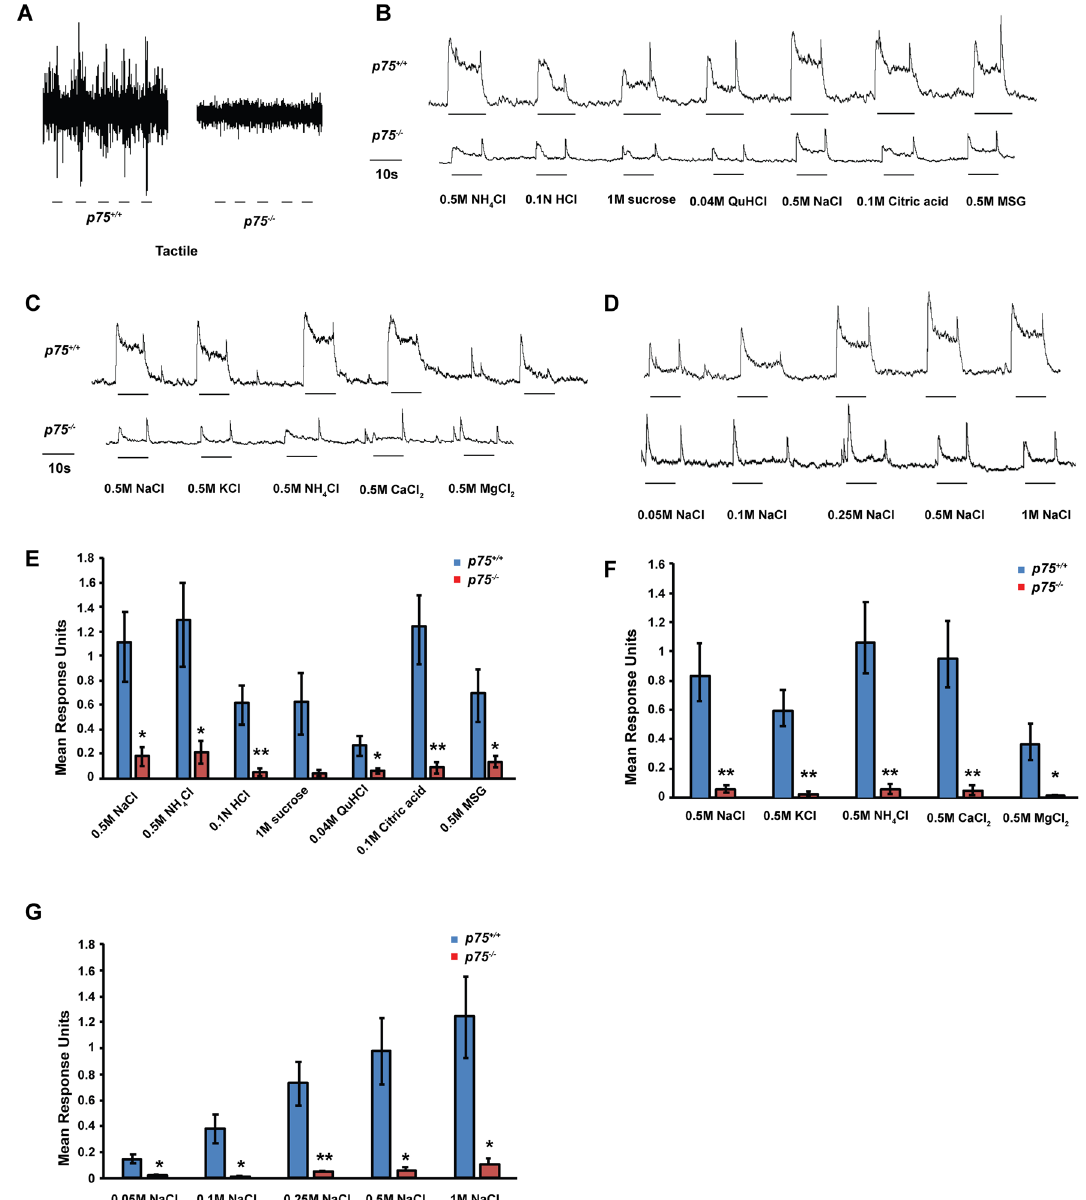
Figure 2. Both tactile and taste responses are reduced in p75 − / − mice. Whole nerve chorda tympani recordings were conducted on p75 + / + and p75 − / − mice at 6–8 months of age. Tactile stimuli, along with sweet, salty, bitter, sour and umami tastants, were applied to the tongues of these mice and the responses recorded. ( A ) These traces illustrate raw chorda tympani nerve responses to tactile stimuli. ( B – D ) Chemical taste responses are displayed as summated chorda tympani recordings to salt, acid, sweet, bitter and umami stimuli ( B ), several chloride salts (0.5 M, C ) and a series concentration of sodium chloride ( D ). ( E – G ) Quantification of average absolute units of chorda tympani nerve responses (mean ± standard error) for p75 + / + and p75 − / − mice. ( E ) Salt (0.5 M NaCl), bitter (0.04 M QuHCl), sour (0.1 Citric acid) and umami (0.5 M MSG) responses were significantly reduced in p75 − / − mice. Sweet (1 M Sucrose) responses were not significantly different (p = 0.056) but showed a trend. ( F ) Chloride salt responses were all significantly reduced. ( G ) A concentration series of sodium chloride (0.05 M NaCl to 1 M NaCl) responses also displayed a significant reduction in p75 − / − mice. The traces ( A – D ) are representative responses from a mouse of each genotype, and n = 5 for both p75 + / + and p75 − / − mice ( E – G ). Scale bar is 10 s. * is p < 0.05, ** is p <